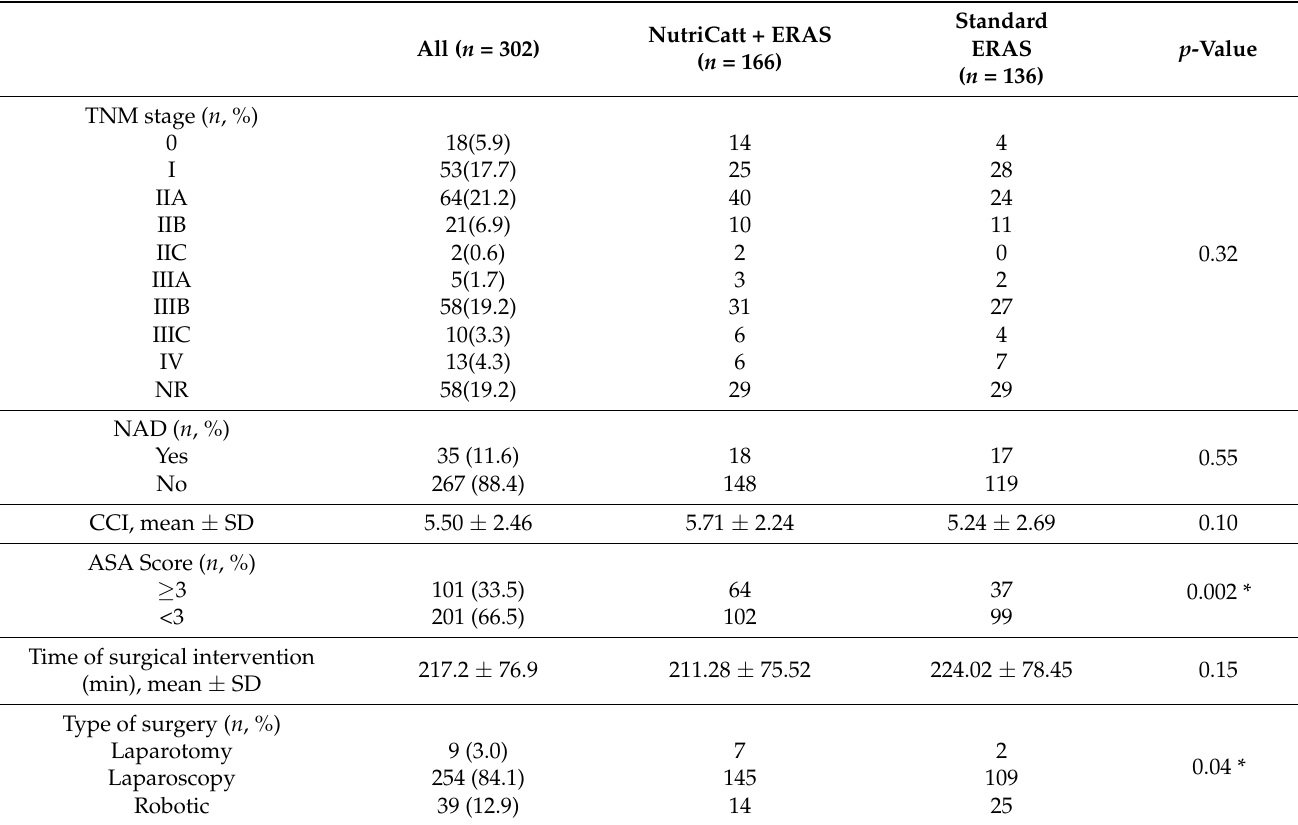
Table 2 details the baseline nutritional characteristics of the NutriCatt + ERAS